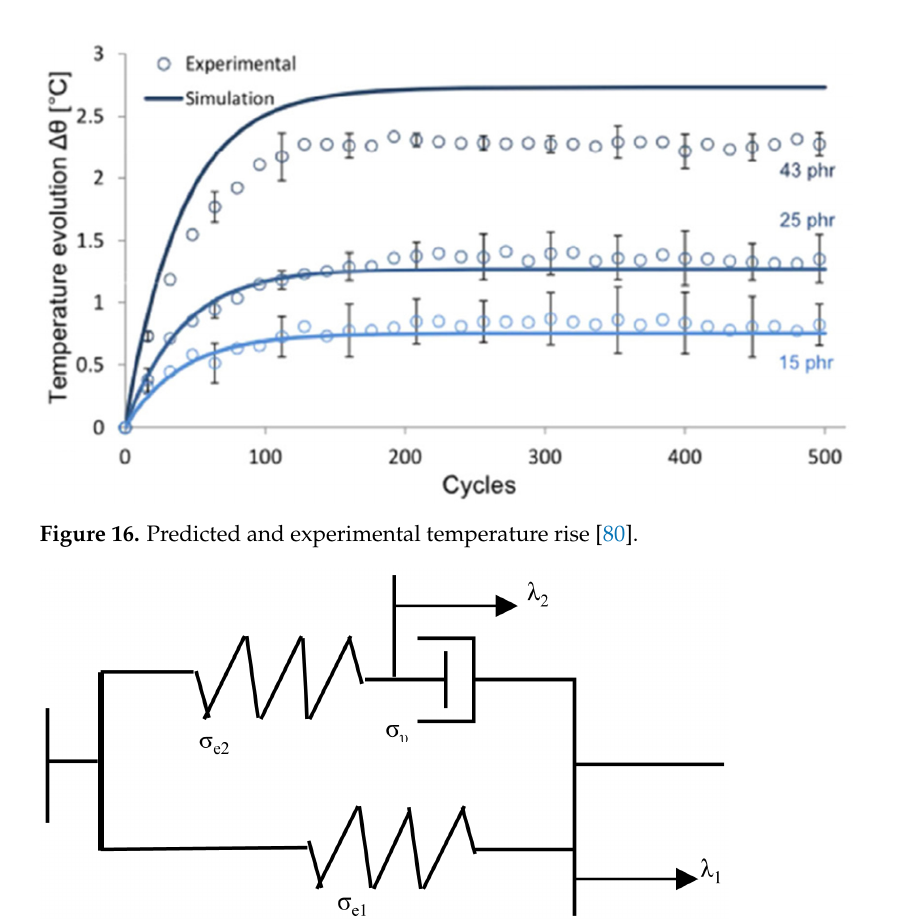
Figure 18. Temperature changes versus strain under different loading conditions [81]. However, in order to use this technique on rubber composites, some questions need to be further investigated. For example, a quantitative interpretation of the temperature changes of different rubber composites under different loading modes is required. Heat conduction in the rubber composites and heat convection from the surface of the rubber composites to the outside air should be taken into consideration. 4.3. FEM FEM is one of the simulation methods to solve differential equations. Temperature rise in rubber composites by FEM is conducive to guide the molecular structure and for- mula design of rubber composites.